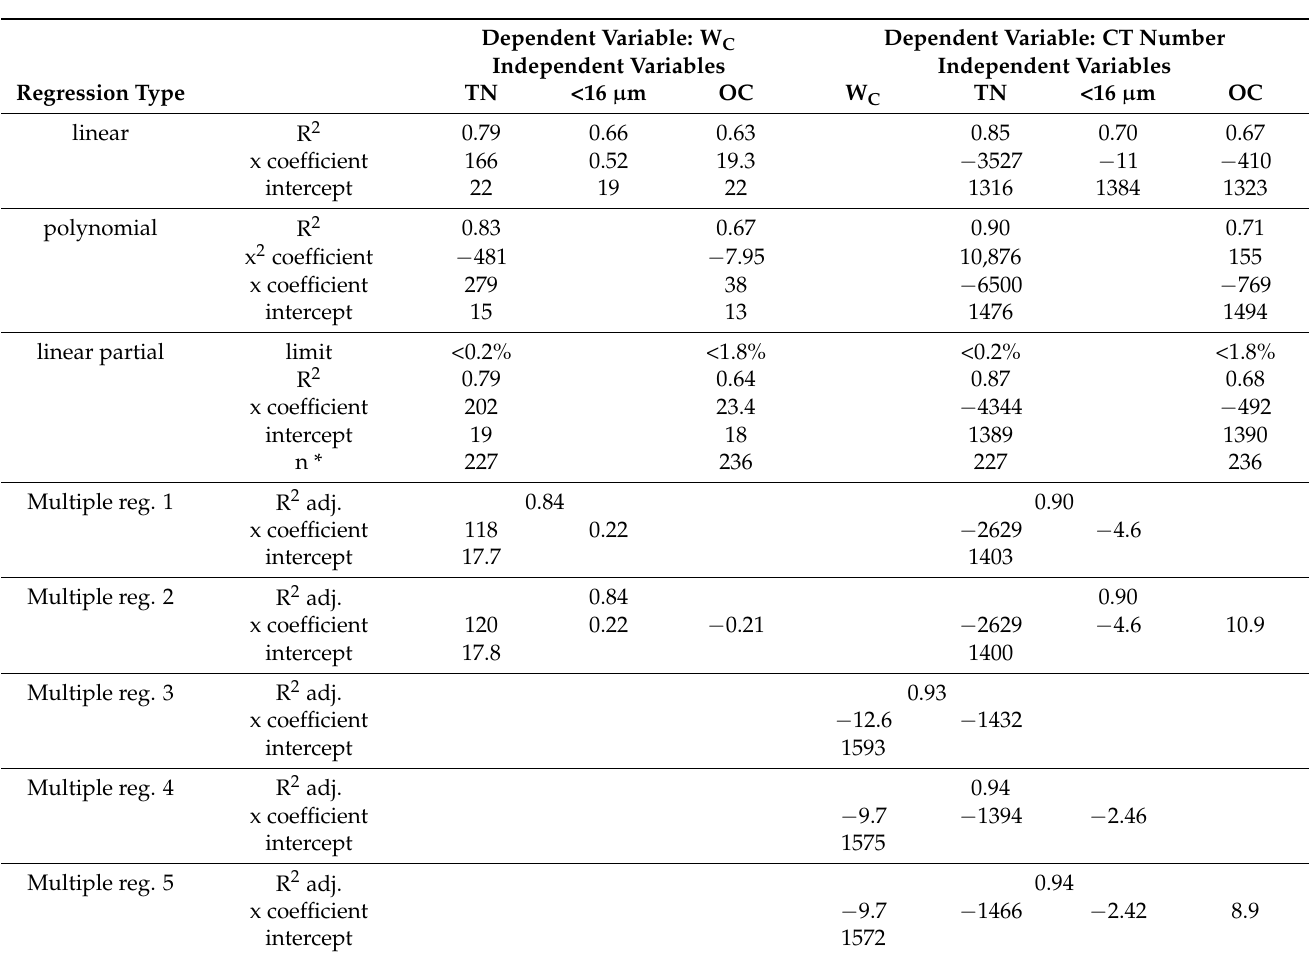
Table 3. Regression statistics for water content and CT number as dependent variables. * number of samples; it is 252 when not